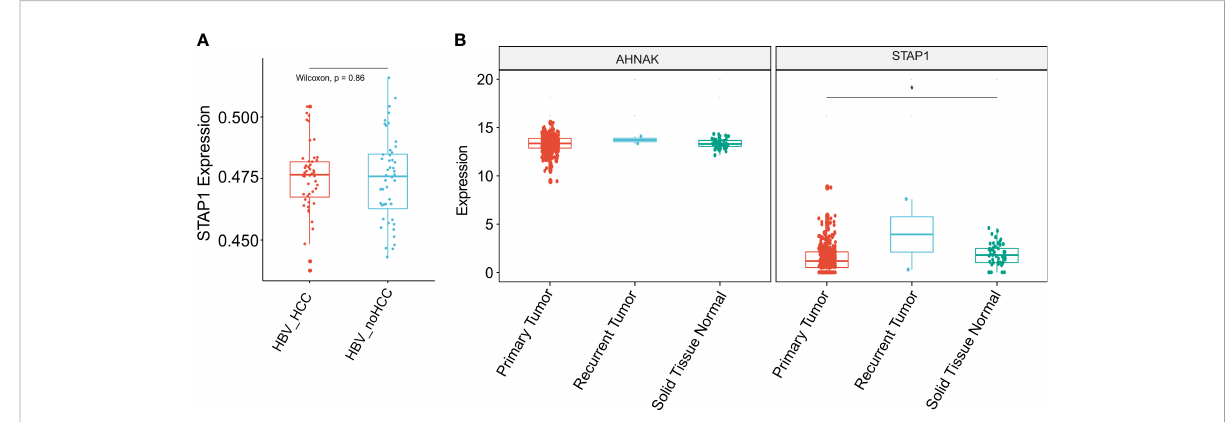
FIGURE 4 Comparison of the methylation and expression of AHNAK and STAP1 between hepatocellular carcinoma (HCC) and normal patients. (A) Comparison of the methylation level of STAP1 between HBsAg carriers who developed HCC and HBsAg carriers who did not. (B) Comparison of the expression level of AHNAK and STAP1 between tumor and normal tissues in The Cancer Genome Atlas data. * P <